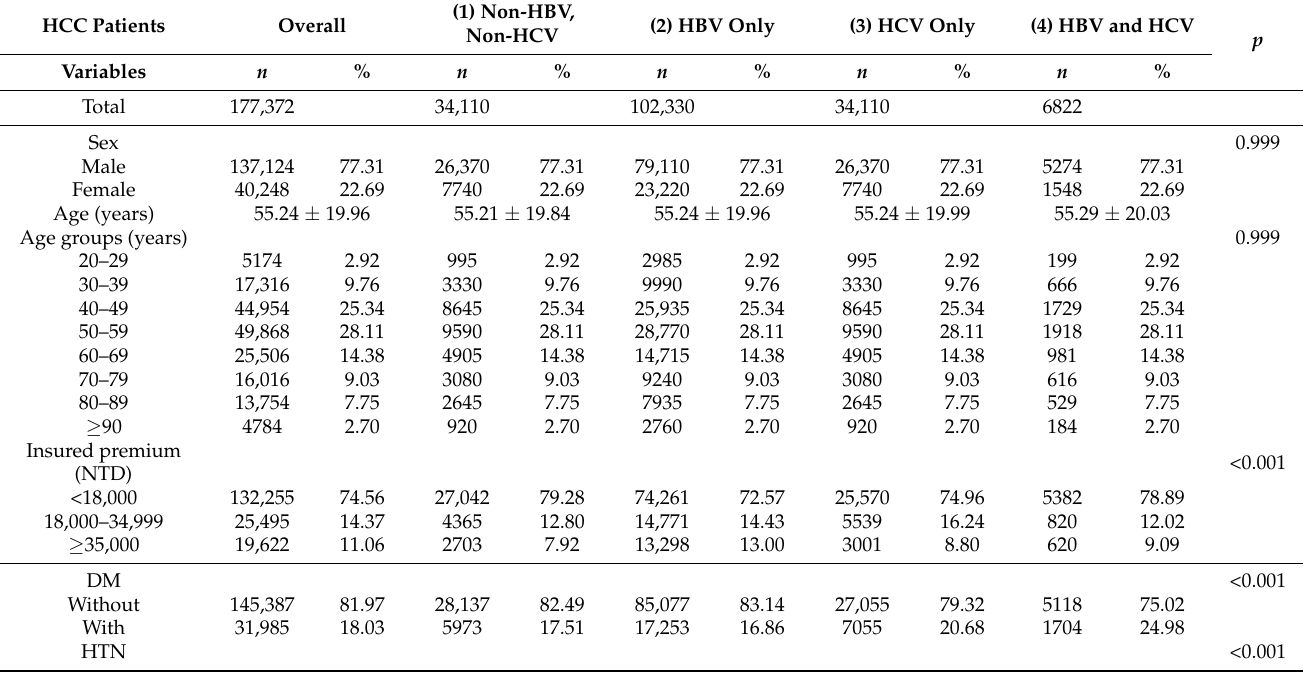
Table 1. Characteristics of study at the